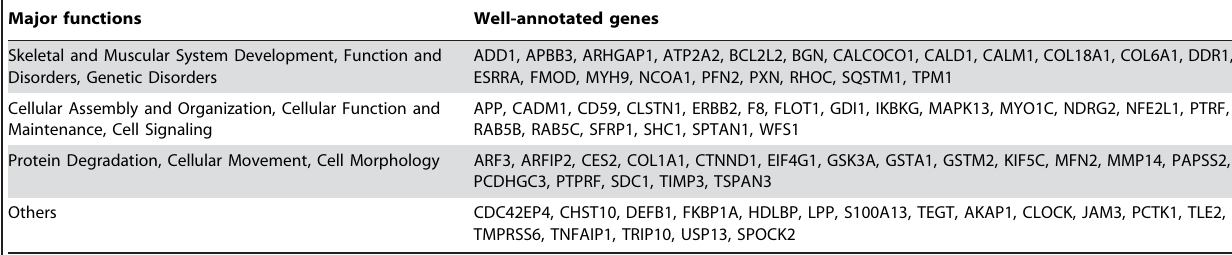
Major functions Well-annotated